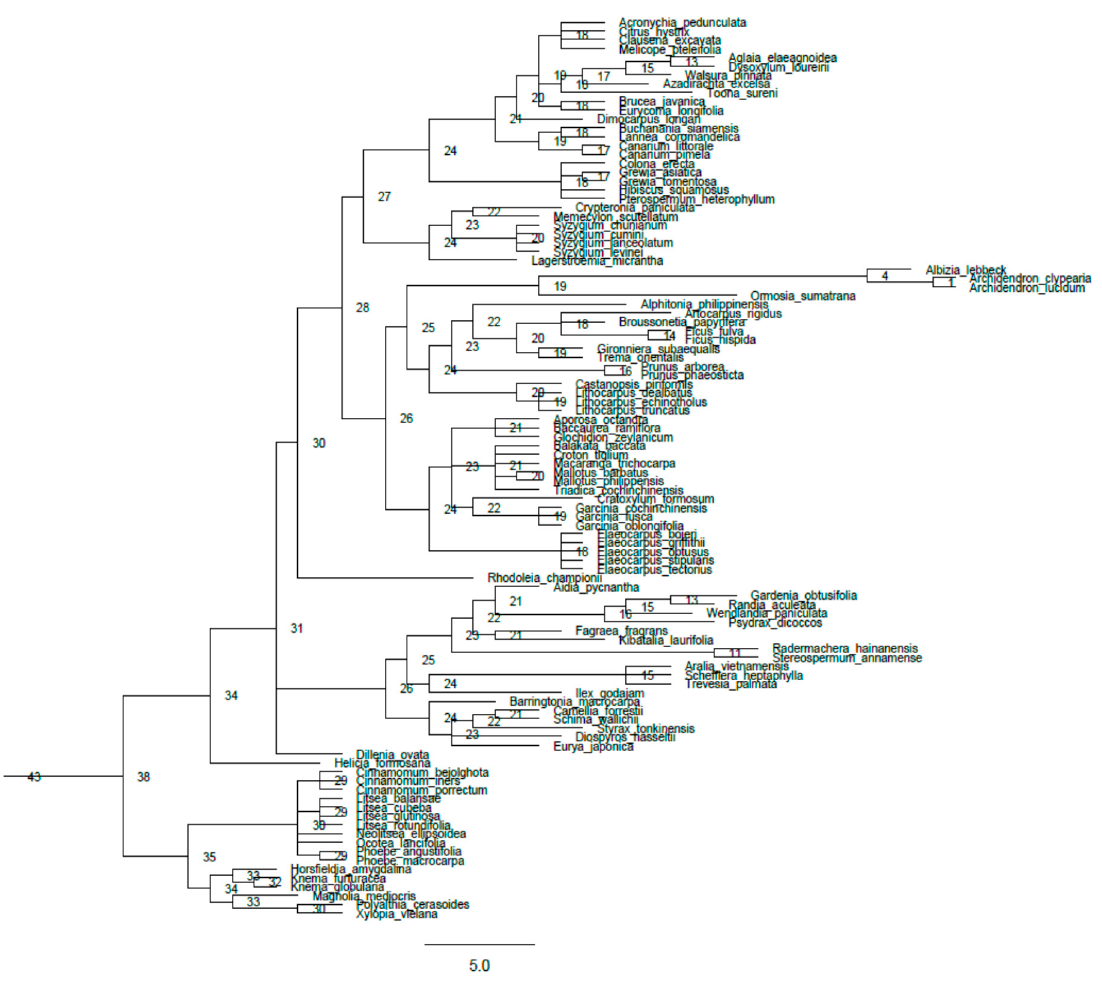
Figure A2. Phylogenetic tree of SF1.